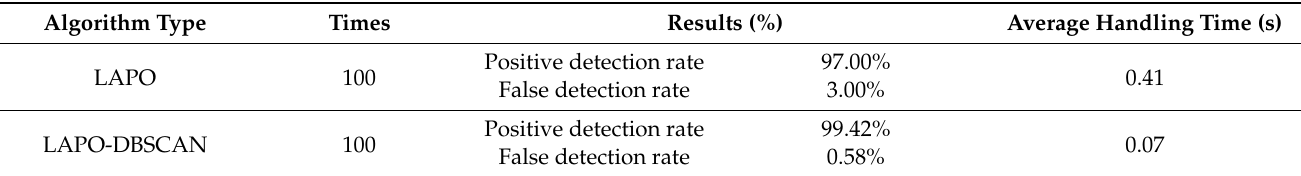
Table 2. Actual scene test results.